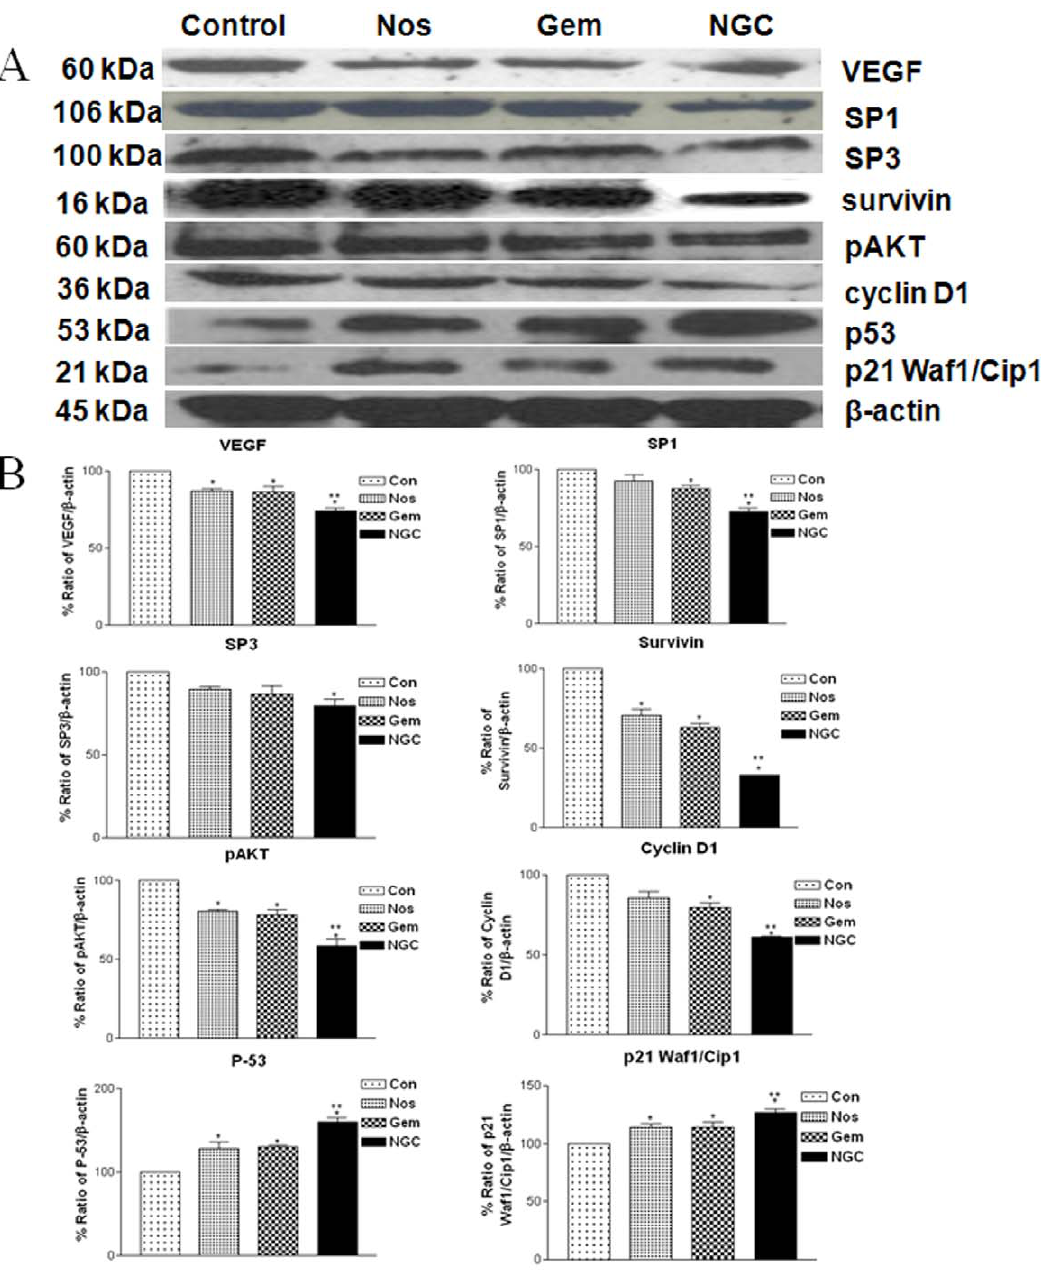
Figure 4. Expression of VEGF, SP1, SP3, pAKT, cyclin D1, p53, p21, and survivin proteins in tumor lysates by western blotting (A) and (B) quantitation of apoptotic protein expression. Lane 1, untreated control tumors; lane 2, oral Nos 300 mg/kg; lane 3, Gem 30 mg/kg i.v. bolus, q3d 6 7 schedule ; lane 4; NGC. b -actin protein acts as a loading control. Similar results were observed in triplicate experiments. Protein expression levels (relative to b -actin) were determined. Mean 6 SE for three replicate